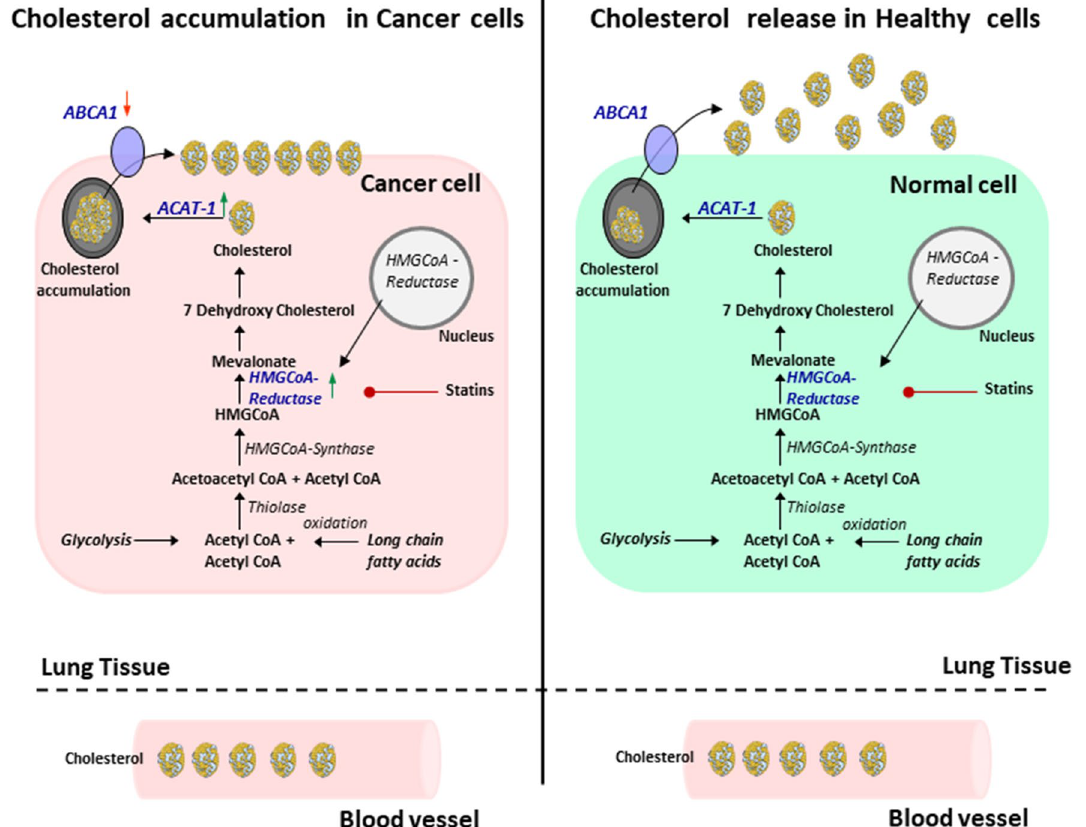
Figure 6. Overview of cholesterol metabolism in cancer and in normal cells. The cholesterol metabolism has many important biological functions in normal cells: Among other things, excess cellular cholesterol is converted to cholesteryl esters by the enzyme acyl-coenzyme A: Cholesterol acyltransferase (ACAT) 1 and is then removed from the intracellular spaces. In tumor cells however, the cholesterol is accumulated into the cells which then leads to increased tumor cell growth 15–17 . Parts of the figure were drawn by using pictures